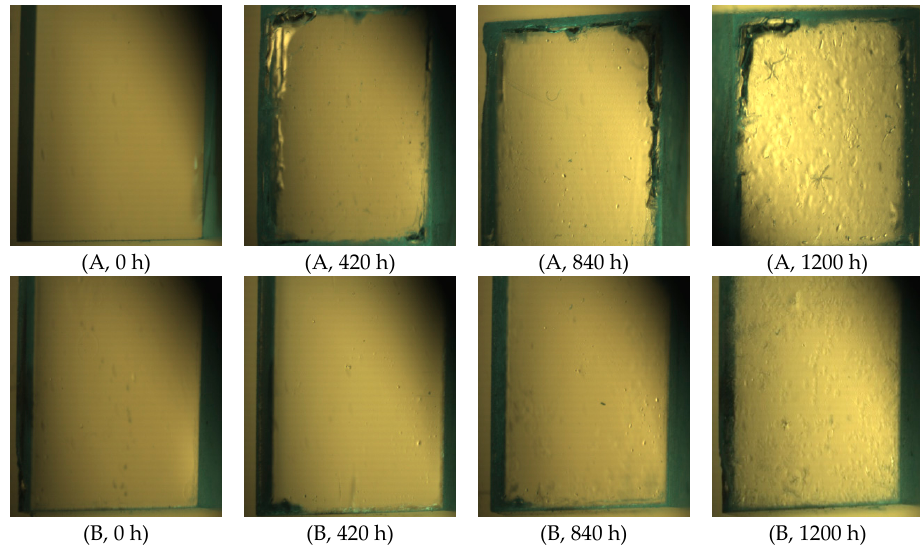
Figure 8. Microphotographs of the (001) plane in ( A ) undoped and ( B ) Al-doped CLBO crystals for different durations.